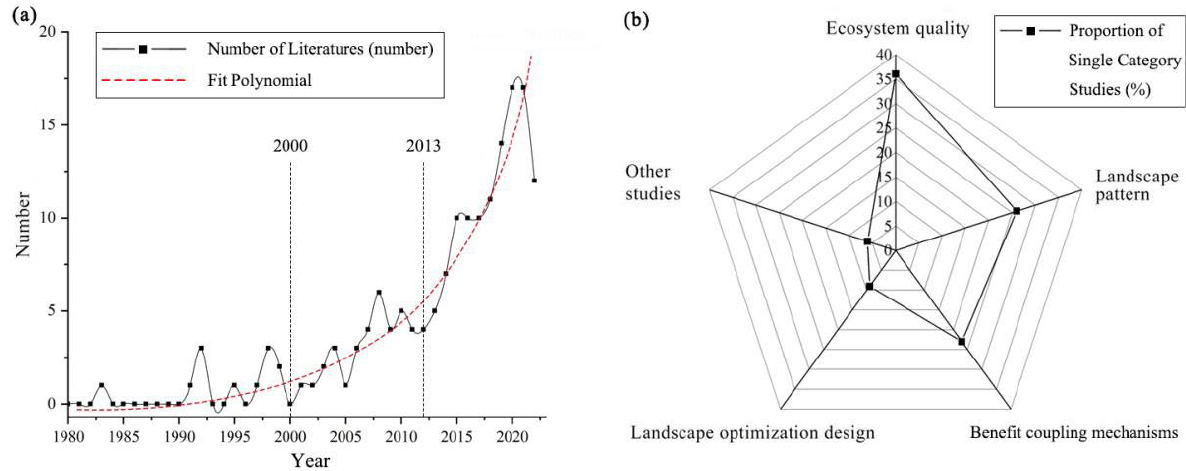
Figure 3. ( a ) Annual distribution of global research literature (From 1983 to 30 June 2022); ( b ) division of research content.